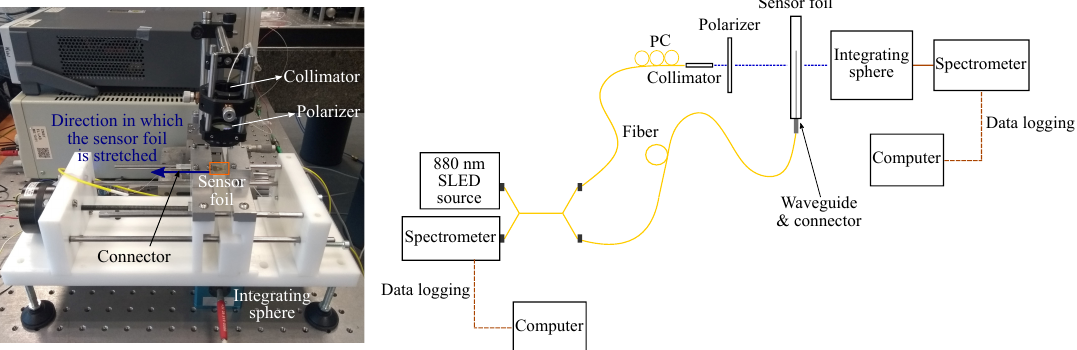
Figure 20. The top view of the sensor with a waveguide Bragg and GMR grating.